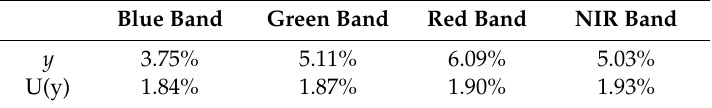
Table 10. The KCRV and its uncertainty in bands 2, 3, 4, and 8 of Sentinel-2B /